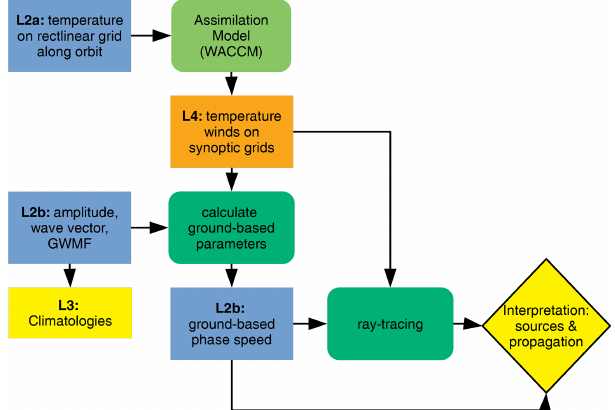
Figure 19. Processing chain for scientific interpretation of prop- agation, source identification, and critical-level filtering. In order to determine the ground-based frequency and perform ray-tracing background wind velocities for the observation location and time are required. These can be generated as Level 4 data via assimilat- ing various data sets (including the observations described here) in a consistent